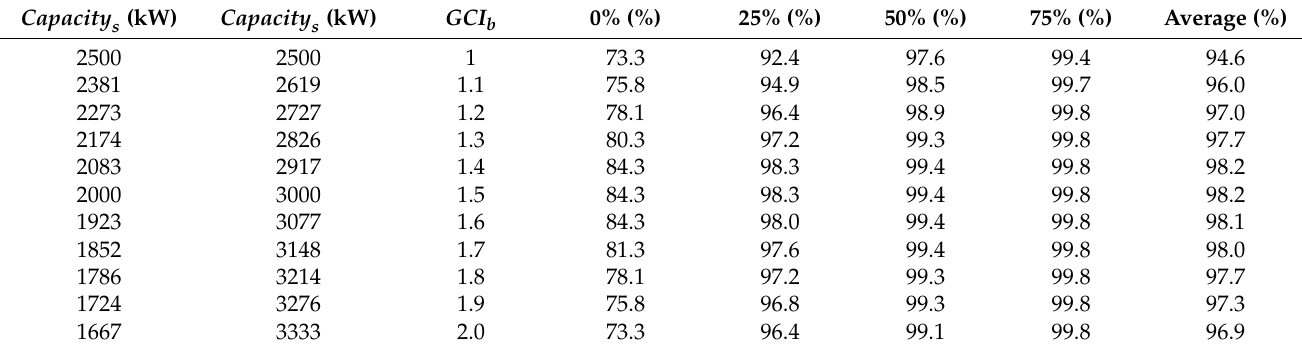
Figure 8. SFOC according to 𝐺𝐶𝐼 (cid:3029) value. Table 3. Distribution of efficiency with GCI b changes.